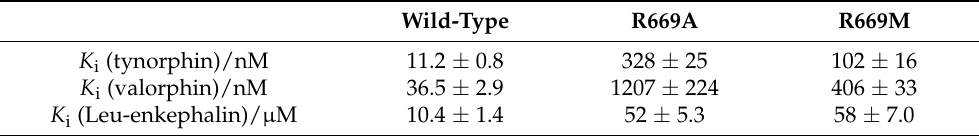
Table 1. Inhibition constants of Leu-enkephalin, tynorphin, and valorphin determined for the DPP III catalyzed hydrolysis of Arg 2